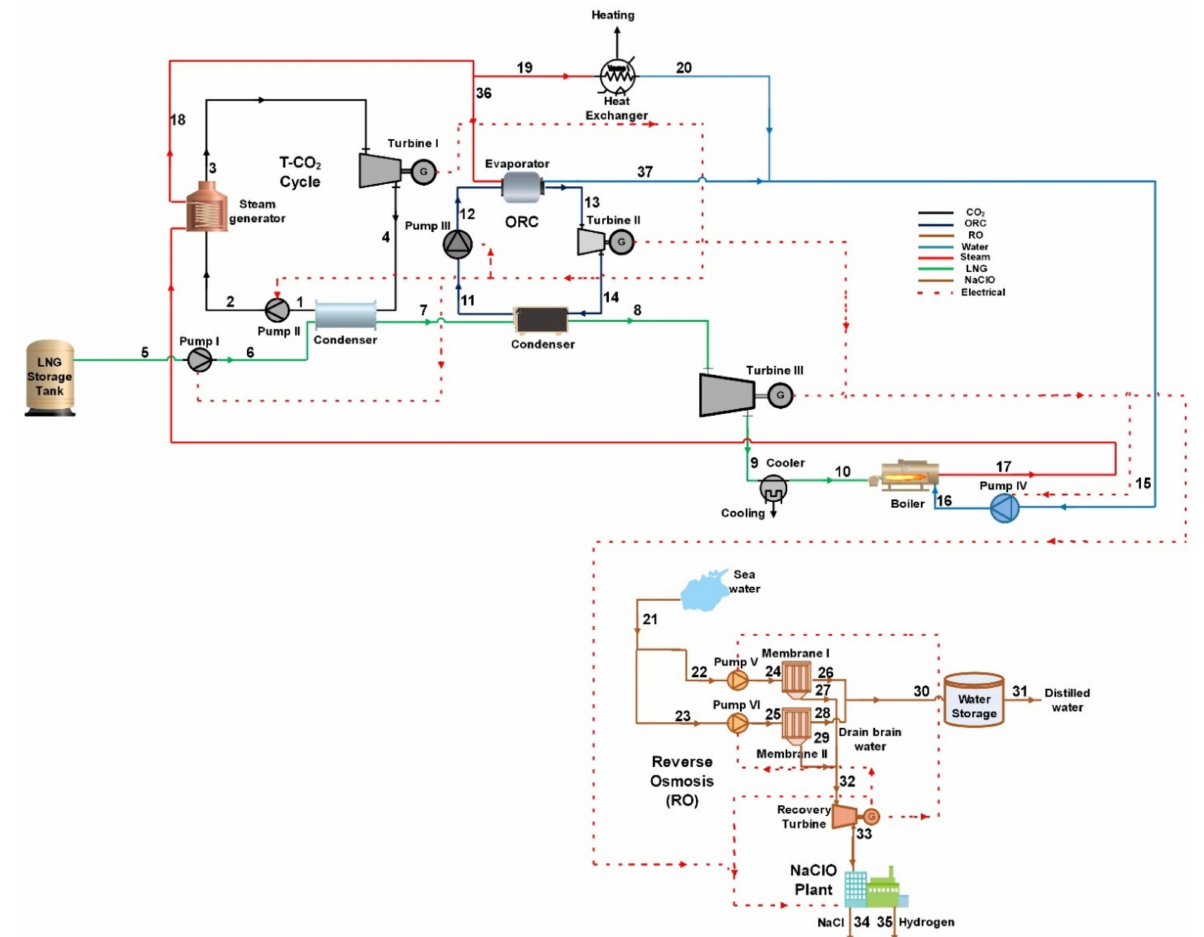
Figure 1. Schematic diagram of the system.